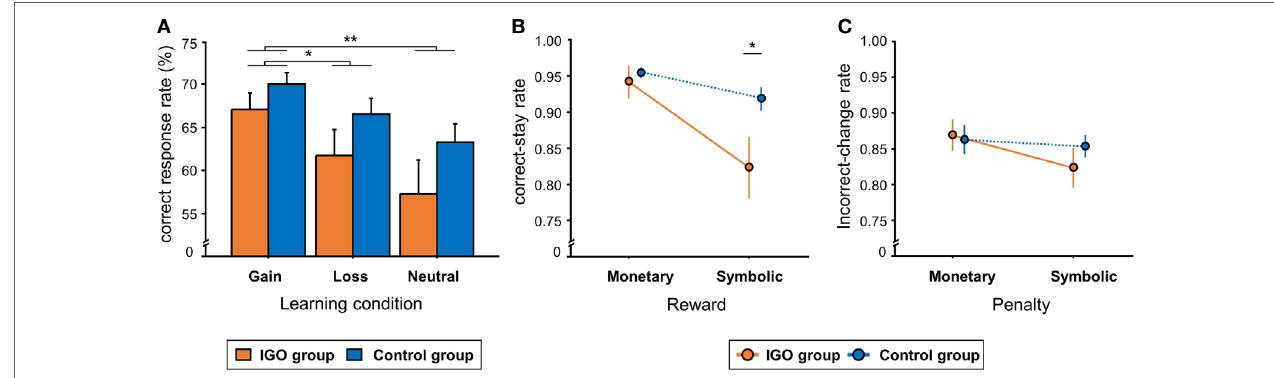
FigUre 2 | Behavioral results. (a) The mean percent of correct response (CR) in the three learning conditions. (B) The group means of correct-stay rate, i.e., the rate of choosing the same CR, following either monetary or symbolic reward. (c) The group means of incorrect-change rate, i.e., the rate of choosing a different response, following either monetary or symbolic penalty. IGO: Internet game overuse; * p < 0.05, ** p <